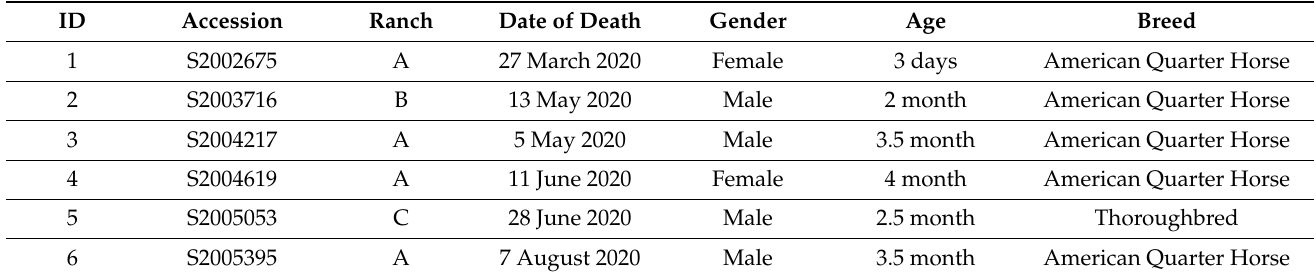
Table 1. Characteristics of